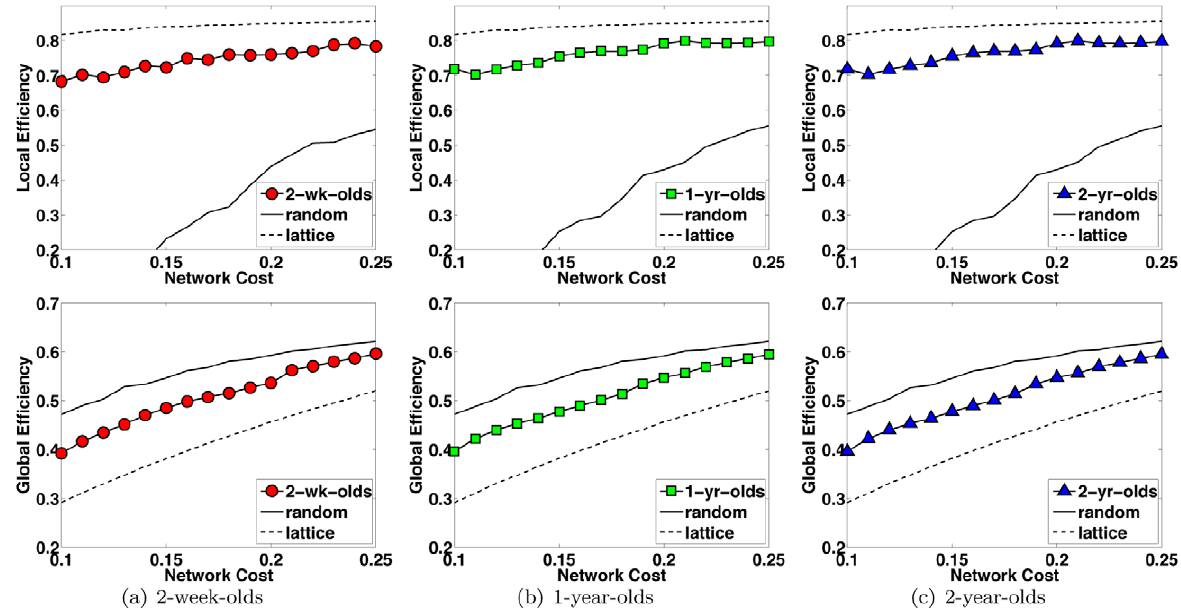
Figure 4. Network Efficiency. Local and global efficiency of pediatric brain networks of (a) 2-weeks-olds, (b) 1-year-olds and (c) 2-year-olds. All networks exhibit small-world nature, which is characterized by local efficiency greater than comparable random networks, and global efficiency greater than regular lattices [5,6]. There is a general trend of efficiency increase with age. The neonatal brain network shows significantly lower efficiency compared to the other two age groups.